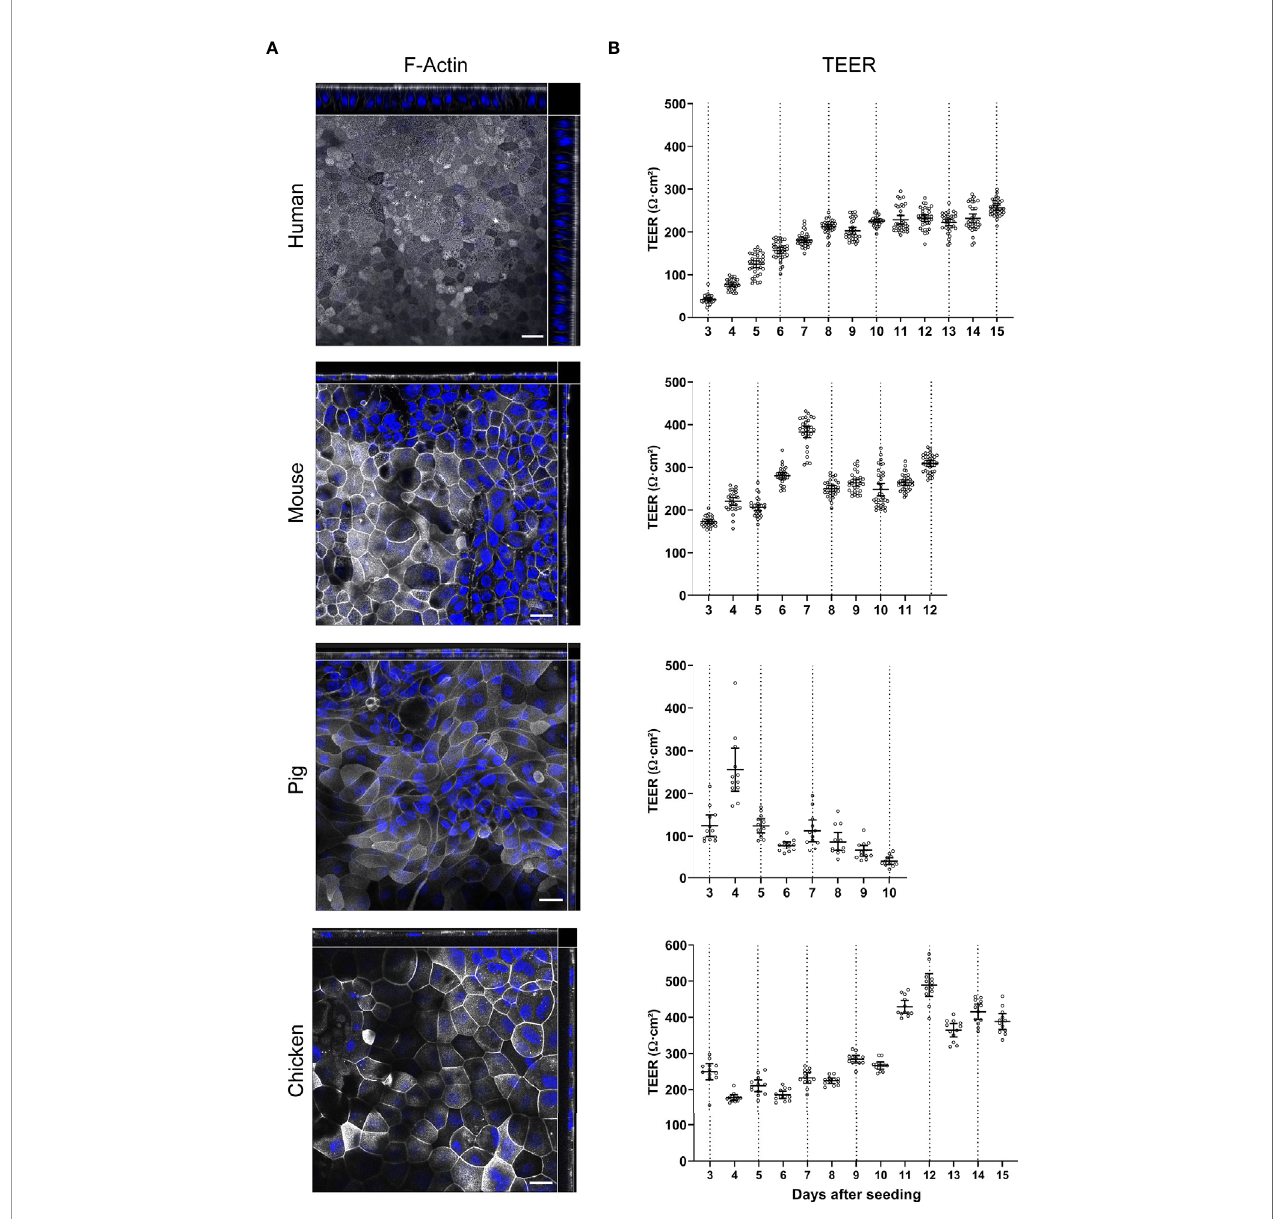
FIGURE 3 | Characterization of TEER development and brush border orientation of ODMs from human, mouse, pig and chicken origin. Spheroids of all four species were seeded on transwell inserts and cultured in differentiation media. (A) Representative orthogonal images of z-stacks showing F-actin accumulation in the apical brush border of ODMs. ODMs were fi xed after 10 (human), 12 (mouse), 6 (pig) and 15 (chicken) days and F-actin was visualized using phalloidin (white) and nuclei using DAPI (blue). Scale bars represent 20 µm. All experiments were performed twice with similar results. (B) ODMs of all four species developed electrophysiologically tight barriers as indicated by TEER analysis. Dashed lines represent medium exchanges. Experiments show mean (± 95% CI) of 12 – 36 fi lter inserts per